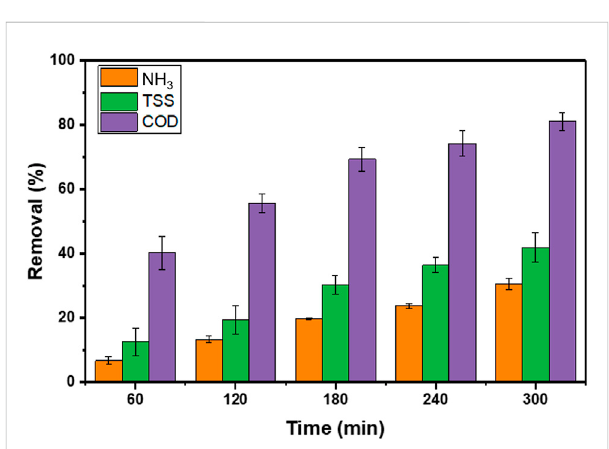
FIGURE 4 The characteristic of water quality parameters of textile wastewater; COD (purple), TSS (green), and NH 3 (orange) during 300 min of